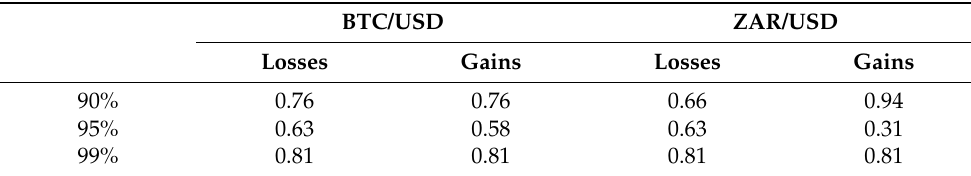
Table 5. Kupiec backtest